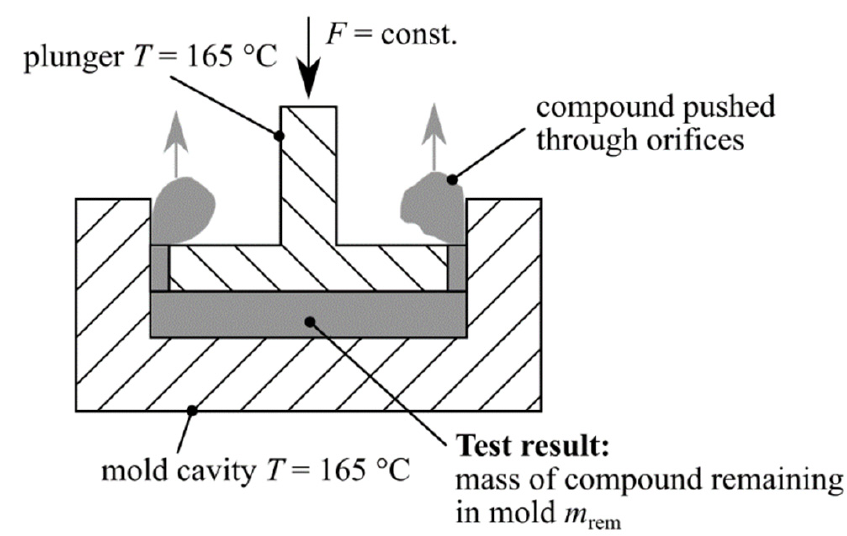
Figure 2. Orifice flow test (OFT) according to ISO 7808